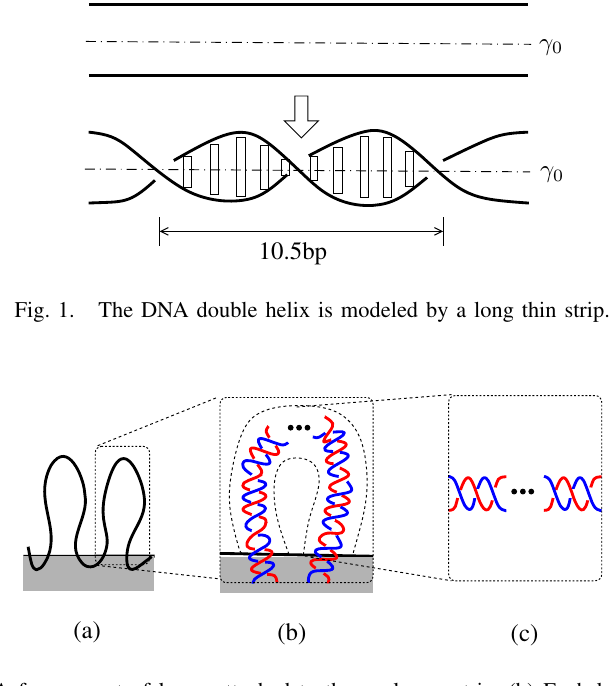
Fig. 2. (a) The linear DNA forms a set of loops attached to the nuclear matrix. (b) Each loop is anchored at the nuclear matrix (NM). (c) The anchored loop is modeled by twisted strings fixed at their ends of the boundary of a 3-dimensional ball, called a